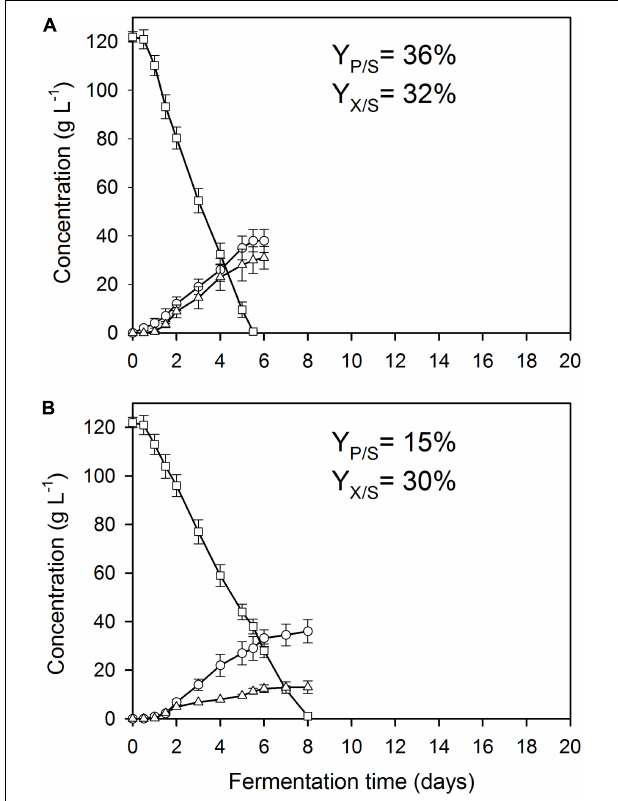
FIGURE 2 | Kinetics of fungal biomass (O), itaconic acid ( (cid:77) ), and residual D -glucose ( (cid:3) ) concentrations in controlled batch fermentations of A. terreus NRRL 1960, grown in a 2-L scale bioreactor in the presence of 300 µ g L − 1 Mn 2 + ions. The variables share the same y -axis as they are expressed in the same unit (g L − 1 ). (A) Culture supplemented with 3.3 mg L − 1 Cu 2 + ions. (B) Culture supplemented with 0.01 mg L − 1 Cu 2 + ions.